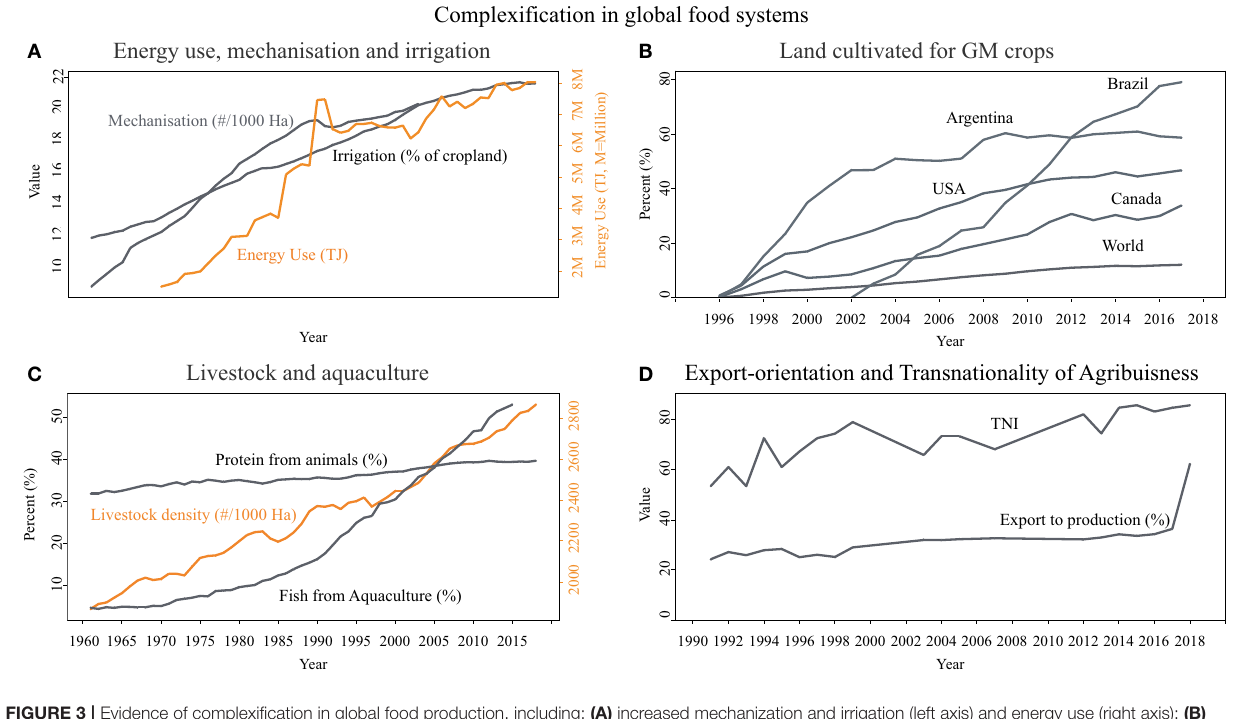
FIGURE 3 | Evidence of complexification in global food production, including: (A) increased mechanization and irrigation (left axis) and energy use (right axis); (B) adoption rates for GM crops globally and for the top four adopting countries; (C) increased reliance on animal-based protein and aquaculture (left axis) and livestock density (right axis); and (D) growth in the export-orientation of food systems, shown as the percentage of exported calories to total calories produced (update of Ercsey-Ravasz et al., 2012) and trans-nationality index (TNI) for the largest corporations in agriculture (update of Senauer and Venturini,